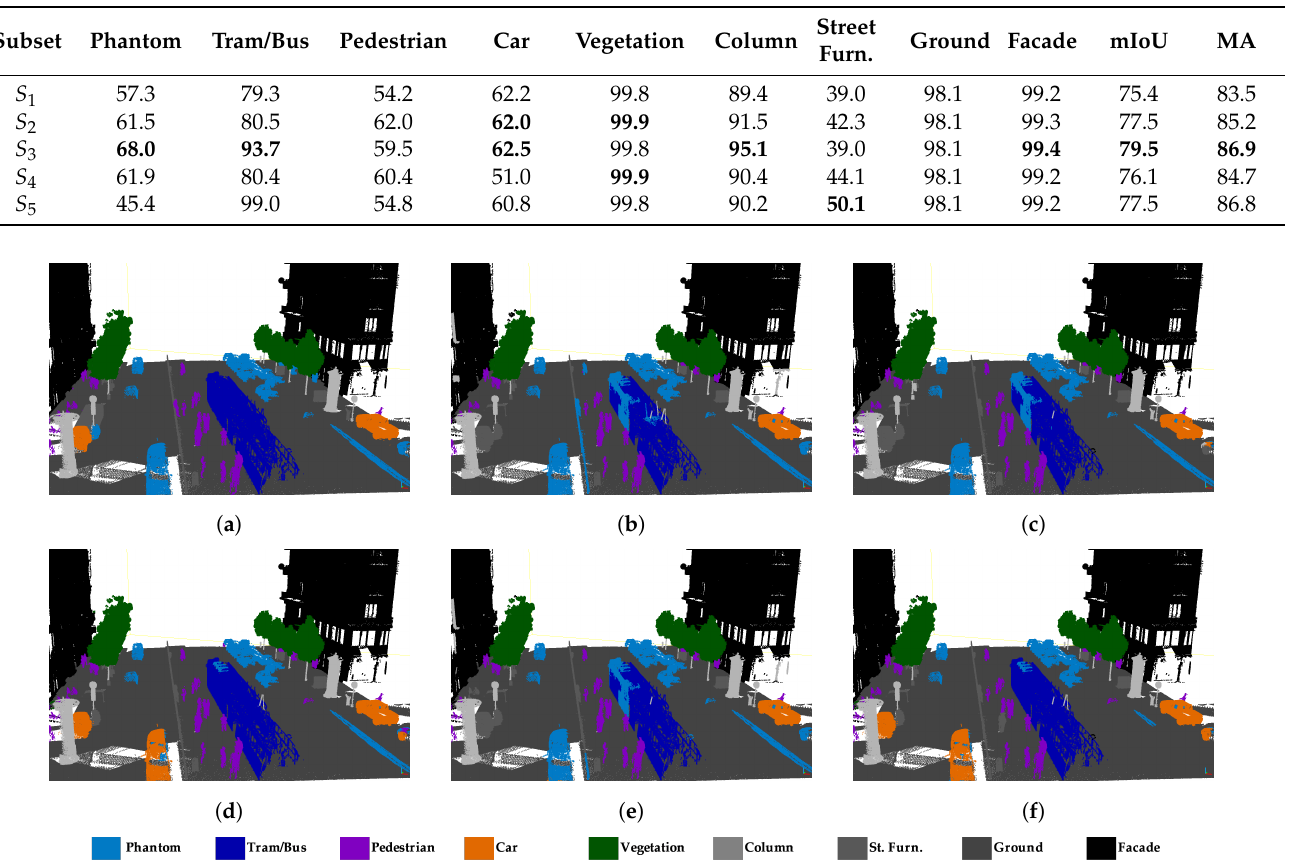
Table 4. Class-based results of SPG on subsets of SZTAKI-CityMLS. Highest values are marked as bold.